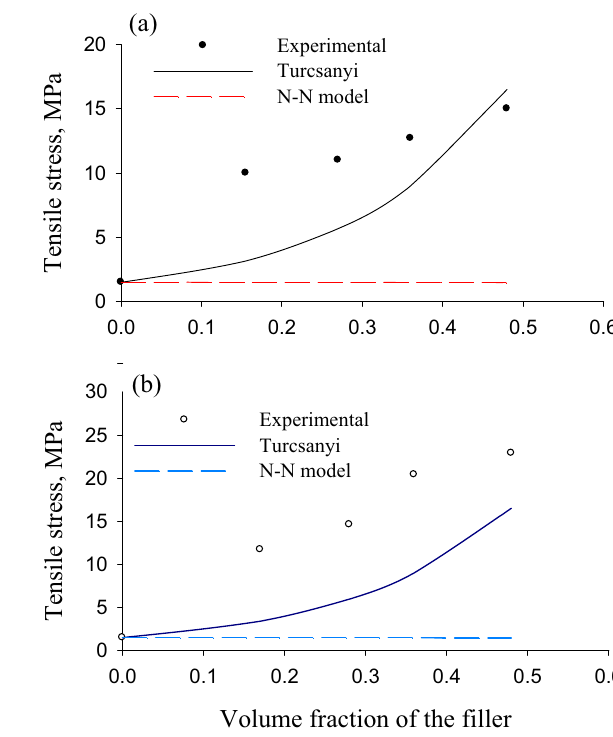
Figure 6: ( a ) Theoretical and experimental values of the tensile strength of CB - loaded NR/IIR blends and ( b ) the e ff ect of TCNP